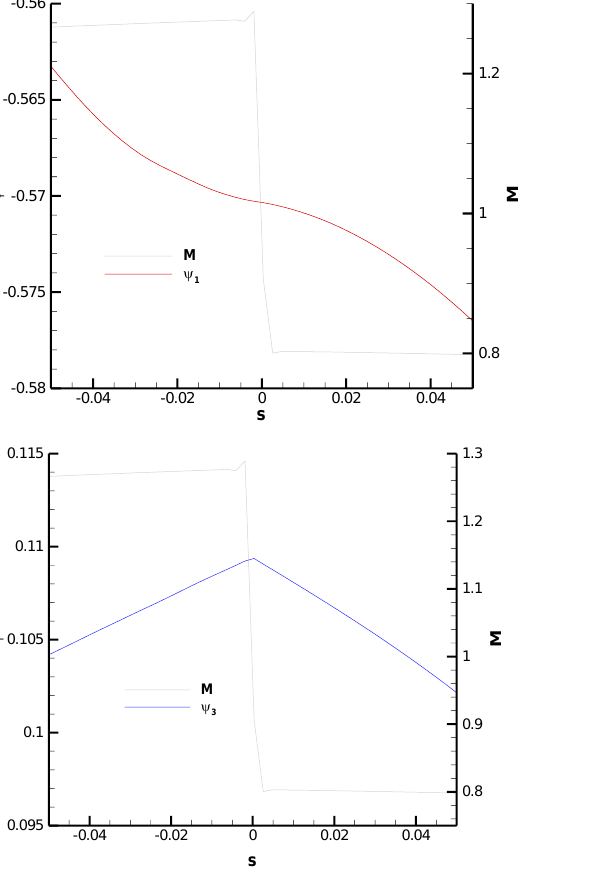
Figure 13. Adjoint variables along the cutting line indicated in Figure 12. Mach number and tangential velocity are also shown for reference.